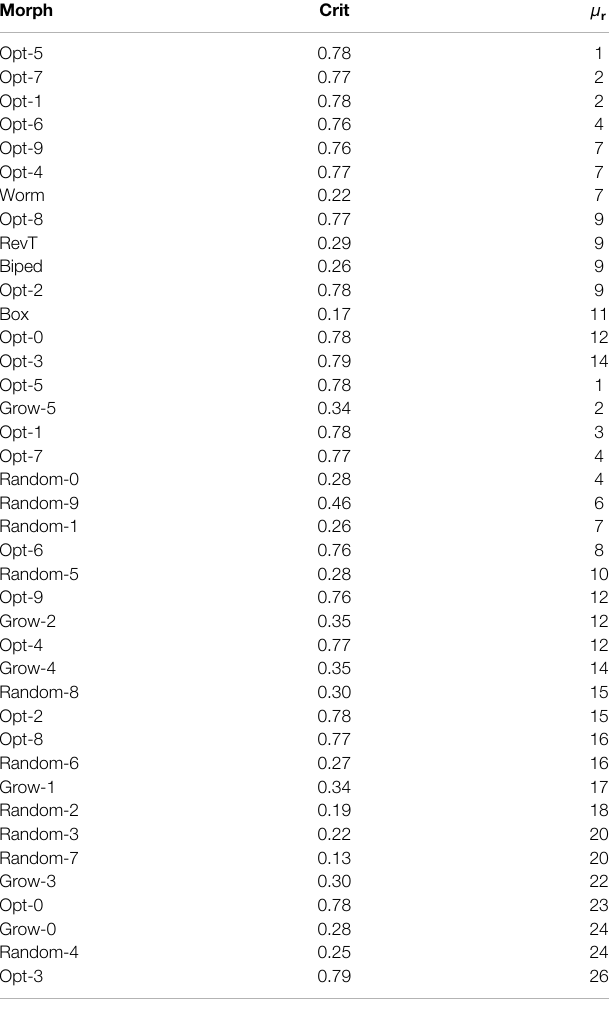
TABLE 3 | Results for the optimized and randomly generated morphologies coupled with the neural controller. For each morphology, the table shows the average rank μ r and the criticality of each morphology; μ r is computed for optimized and handcrafted morphologies, on the left, and for the morphologies obtained with the three task-agnostic procedures, on the